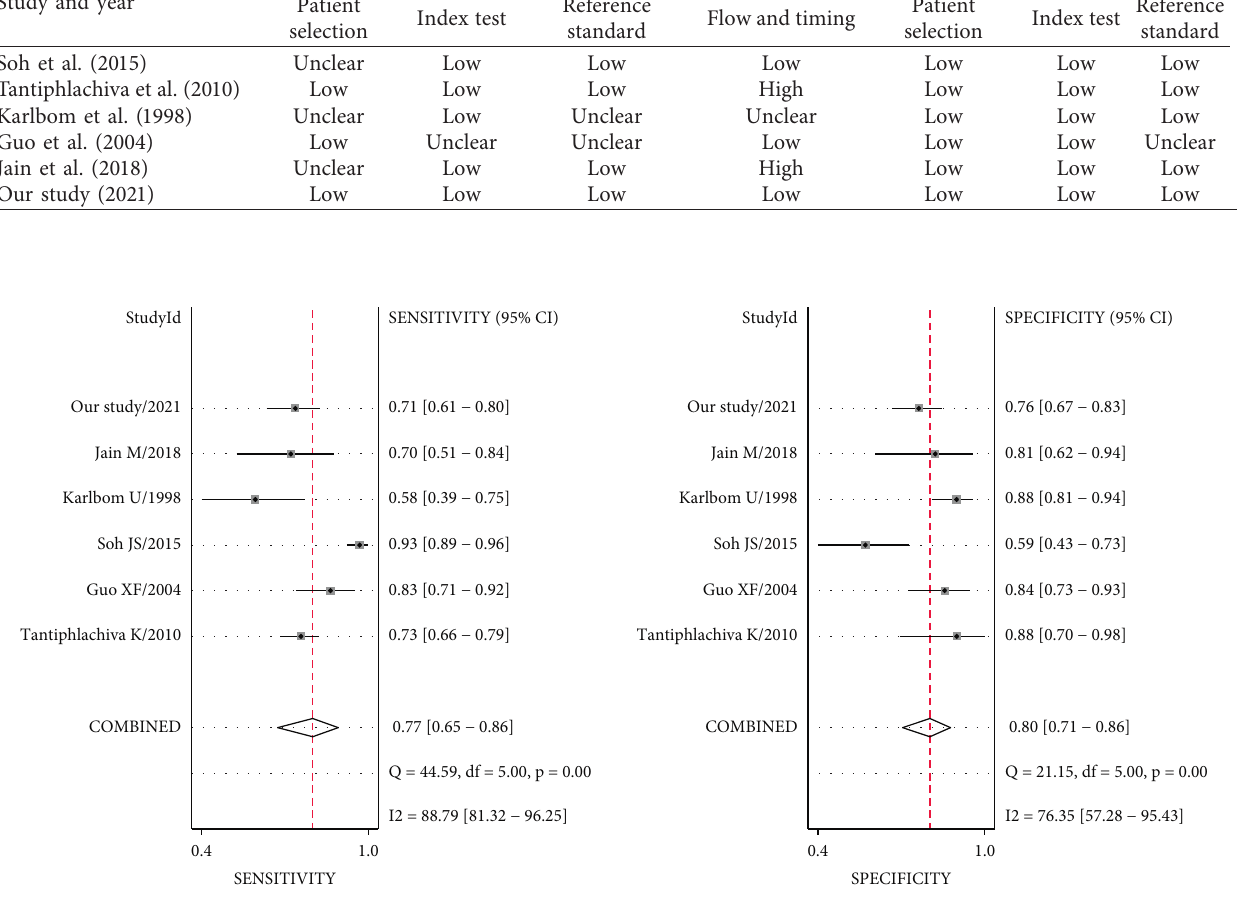
Figure 2: Pooled sensitivity and specificity of digital rectal examination for diagnosis of dyssynergic defecation (the outcome showed 77% summary sensitivity (95% CI: 65–86) and 80% summary specificity (95% CI: 71–86) to diagnose dyssynergic